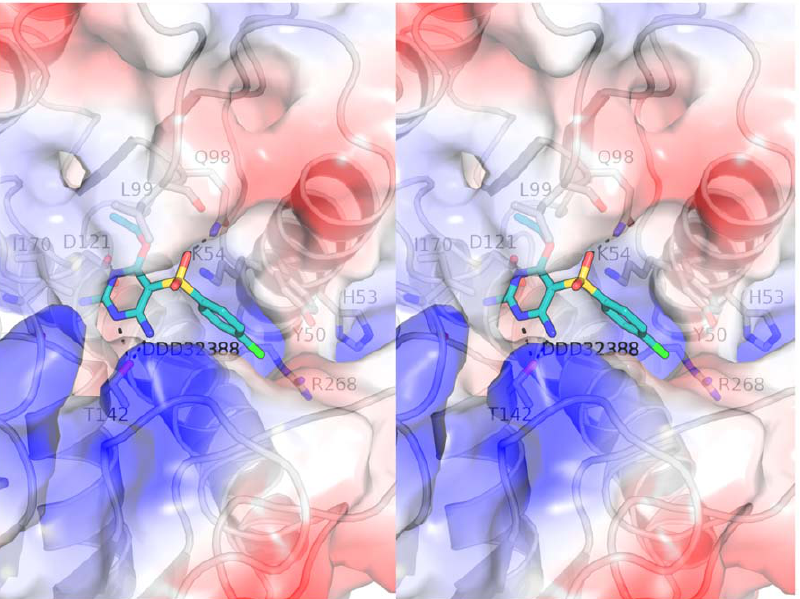
Figure 8. Ligand docking. Stereoview of the docking of DDD32388 (cyan) into the active site of Pa FolD. Potentially important residues are highlighted as sticks and with hydrogen bonds shown as